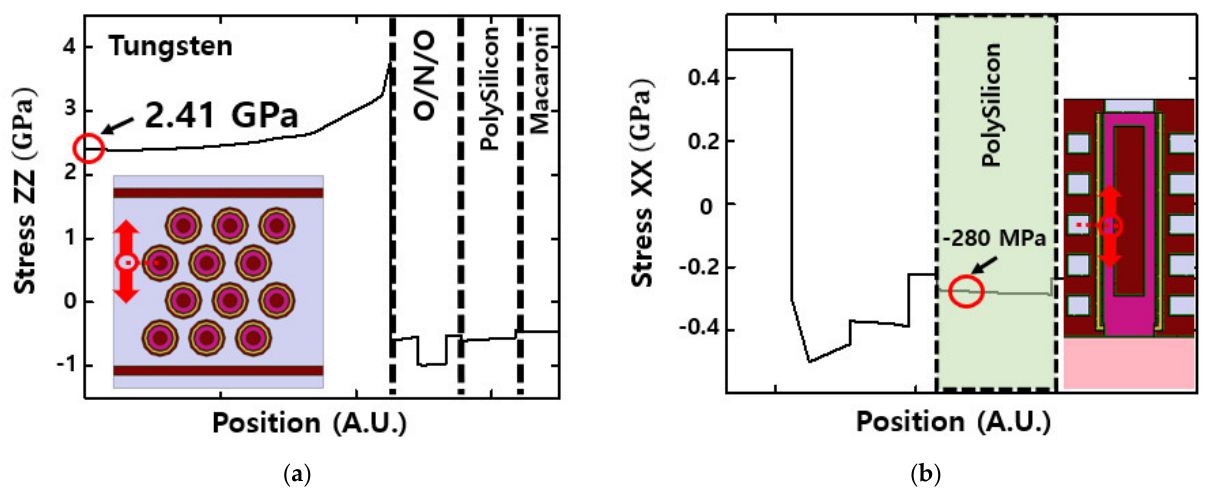
Figure 2. TCAD calibration with the reported experimental data. The residual stress of ( a ) the tungsten film after the tungsten replacement gate process and ( b ) the polysilicon channel in the final structure.